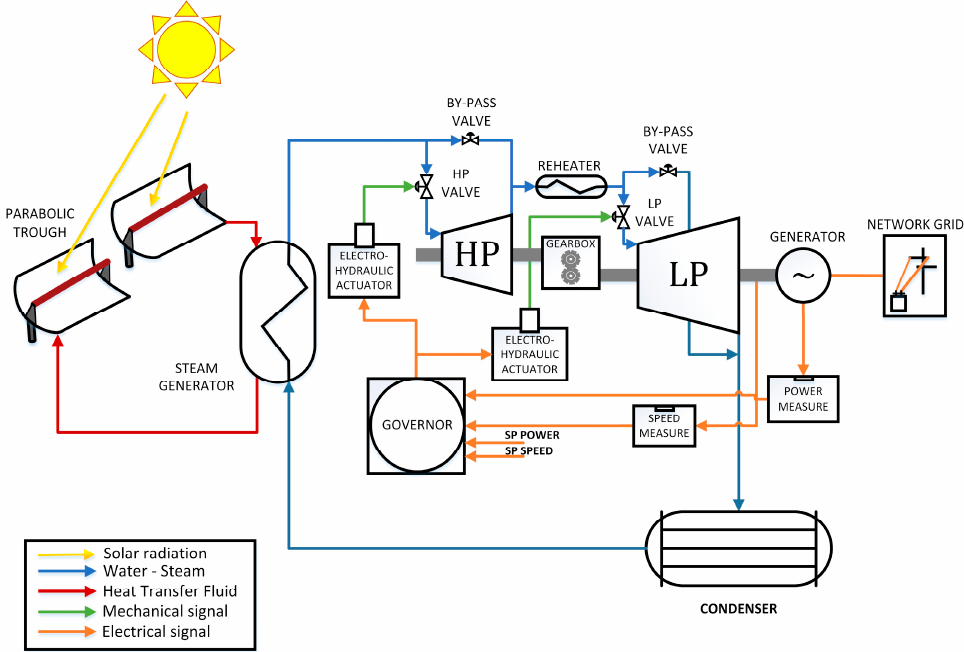
Figure 1. CSP plant schematic diagram considered in the present work.